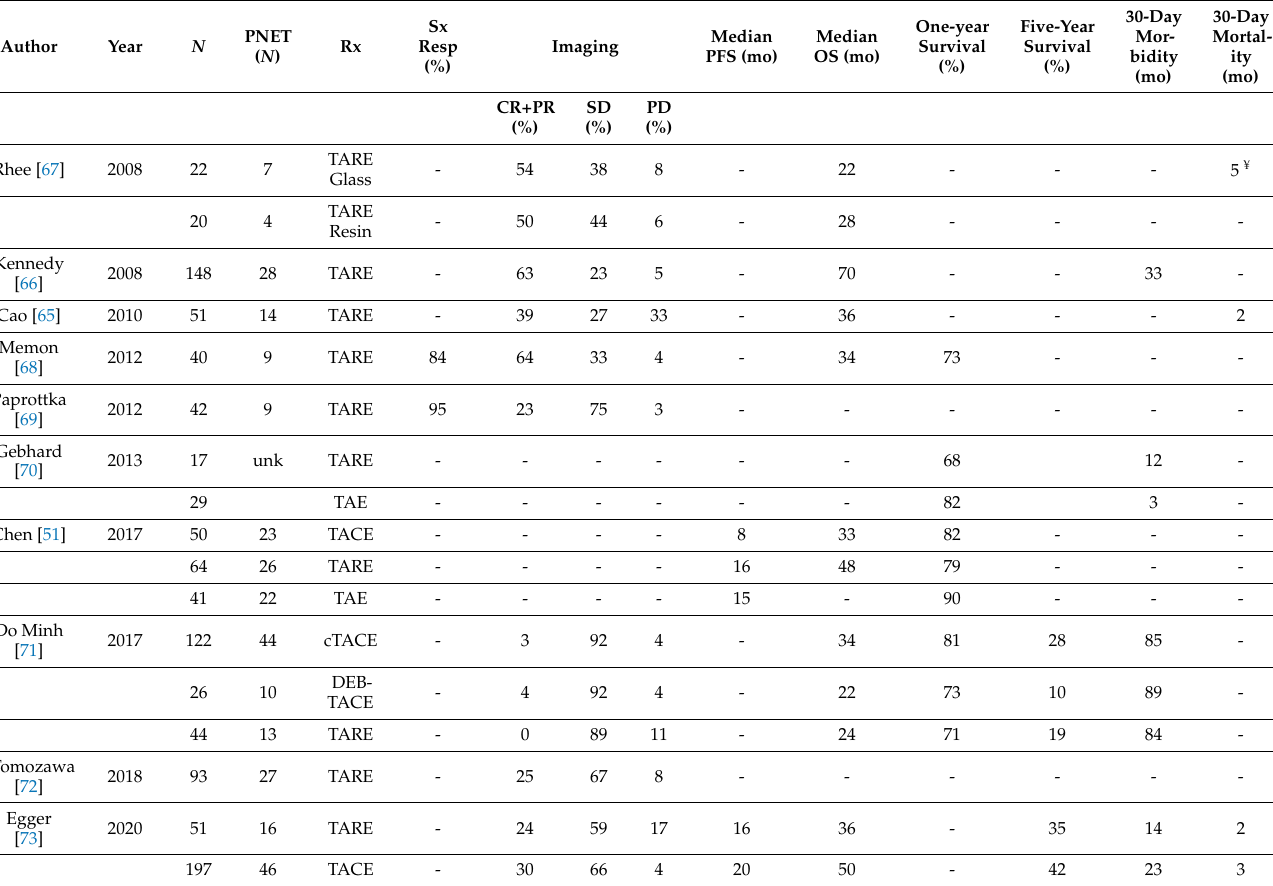
Table 3. Review of literature on transarterial radioembolization (TARE) of neuroendocrine tumor liver